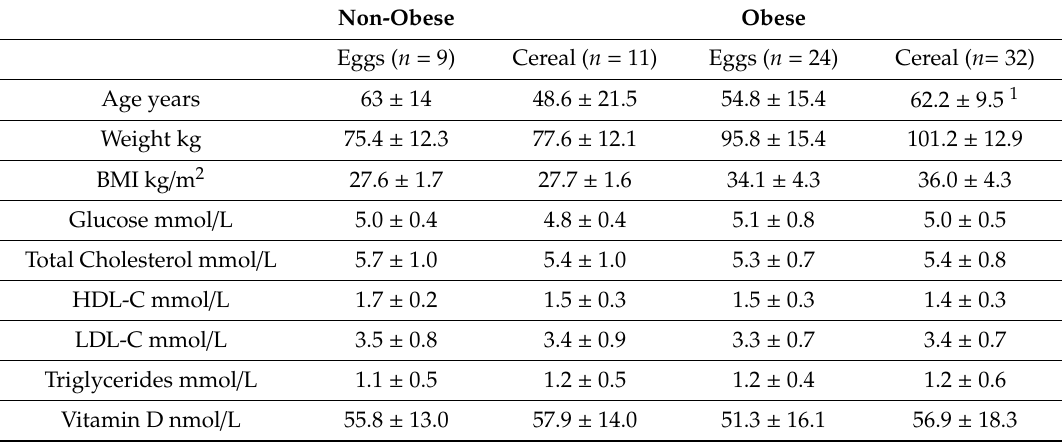
Table 2. Baseline characteristics of non-obese and obese participants at baseline who completed the